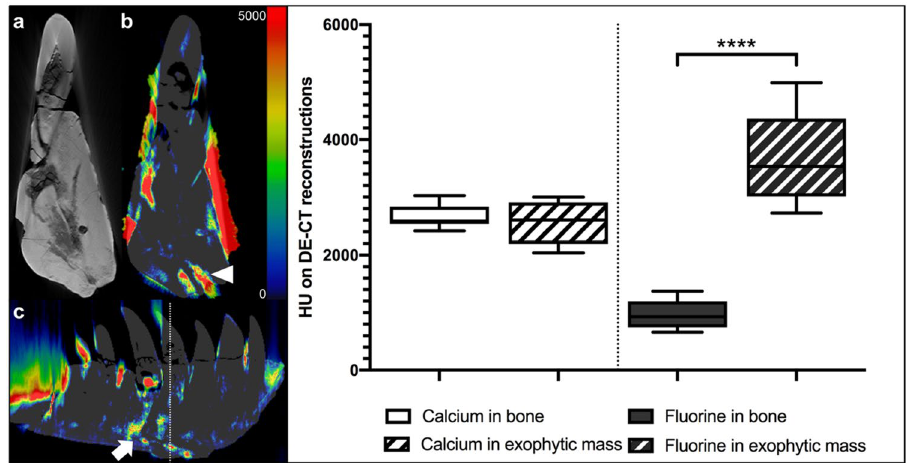
Figure 6. Advanced disease characterization in the left dentary of Tyrannosaurus rex using DECT-based fluorine quantification. Conventional CT reconstruction ( a ) and DECT-based fluorine map ( b ) of the left dentary in coronal plane at the level of the focal exophytic mass showing significant fluorine accumulation in areas of reduced bone density (arrowheads). DECT also revealed increased fluorine accumulation at the base